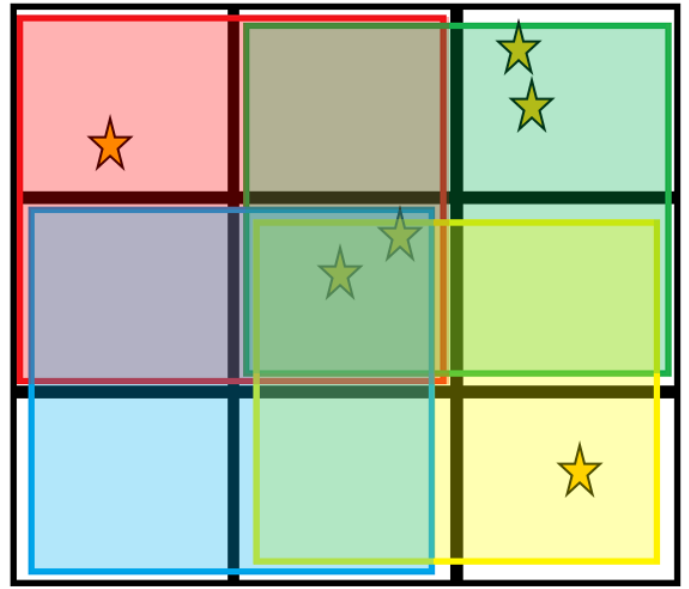
Table 2. A list of the different CSCAs used in this work along with their NS and NL categories. CSCA Label